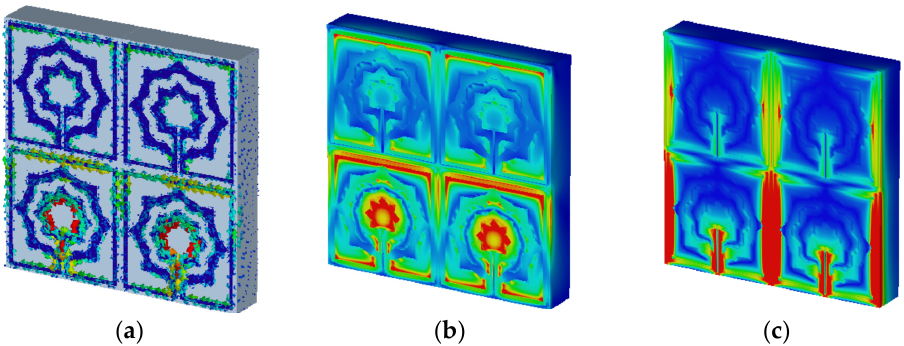
Figure 14. Analysis for 2 × 2 array: ( a ) current distribution; ( b ) magnetic field distribution; ( c ) electric field distribution for resonant frequency 0.25 THz.